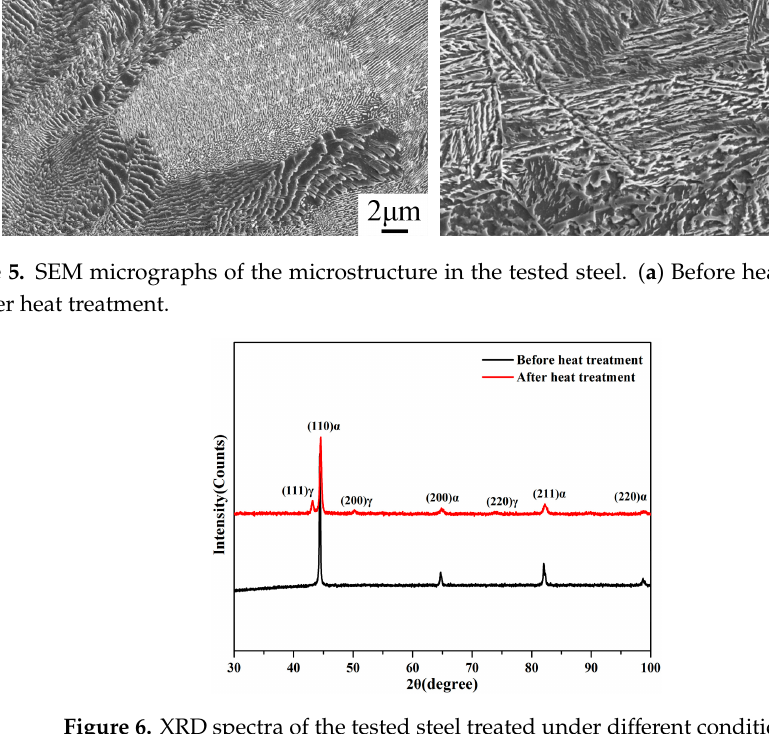
Figure 6. XRD spectra of the tested steel treated under different conditions.